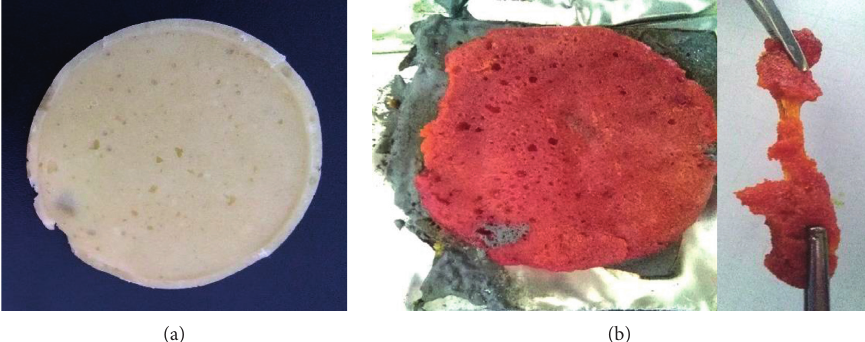
Figure 6: The images of storage of the NEPE propellant with the PEG adhesive network structure: before (a) and after